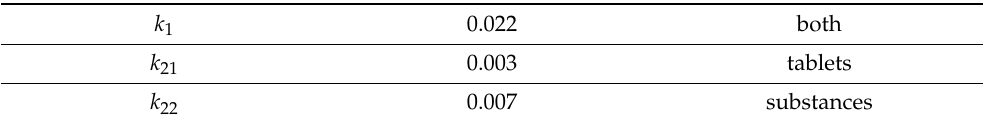
Table 2. The kinetic